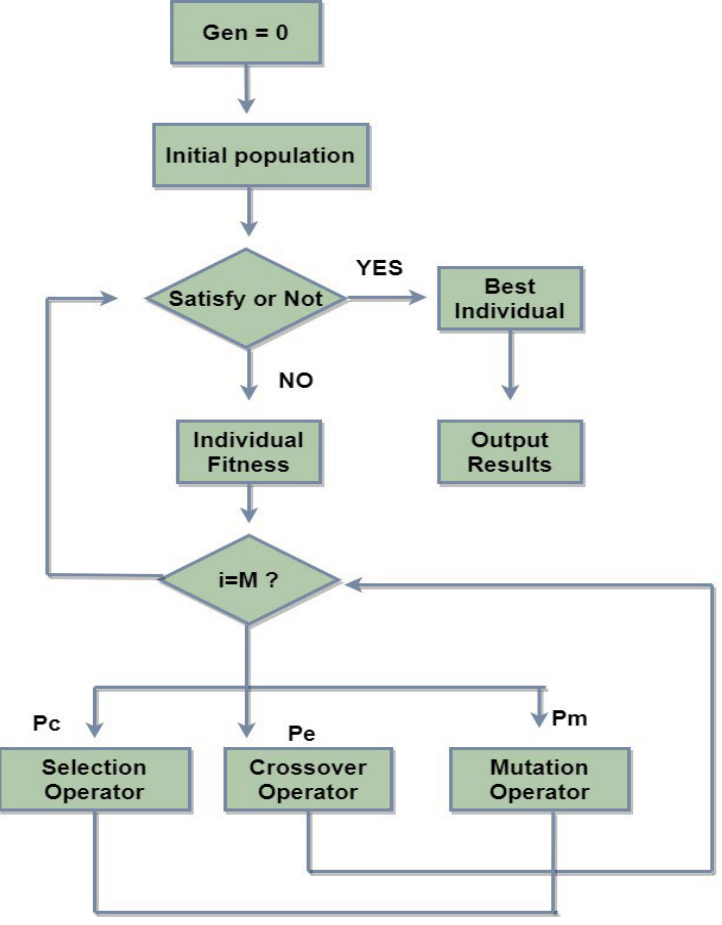
Figure 6. Working phase of the genetic algorithm. Application of Genetic algorithms for biomedical